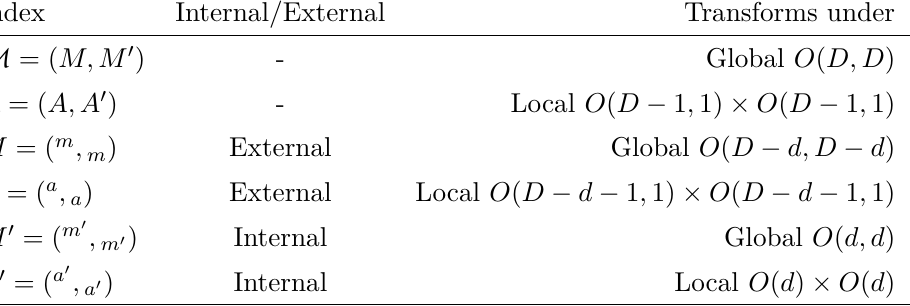
Table 1 . Summary of index